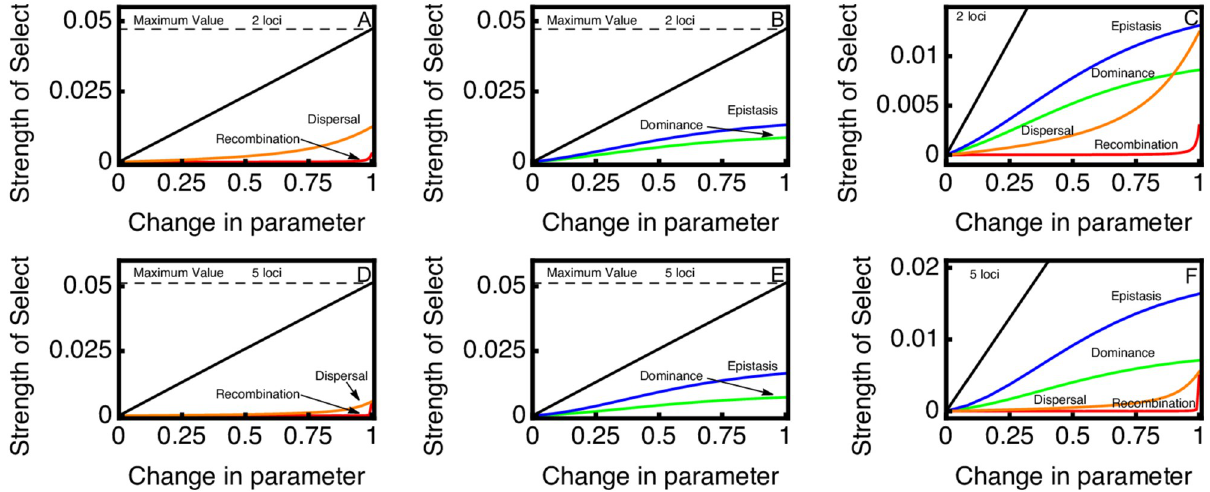
Fig 2. Initial strength of selection on different modifiers as measured by λ − 1. Parameter values for the ancestral population are S = 0.1, M = 0.05, R = 0.5; θ = 0; ϕ = 0. We plot the fraction of the maximum allowable change in the parameter on the x-axis. The dashed horizontal line represents the theoretical maximum for the spread of a modifier, while the solid black line shows the strength of selection for a modifier that reduces the total effect of the maladaptation (i.e. a modifier that reduces S ). Top panels left to right show results for two local adaptation loci, while bottom panels left to right show results for five local adaptation loci. For dominance modifiers, the modifier is assumed to affect dominance at all local adaptation loci simultaneously. Likewise, the recombination modifier is assumed to reduce recombination between all loci simultaneously. We only show positive changes in dominance and epistasis, because negative values have identical effects but indicate that deme 2’s locally adapted allele is instead dominant.